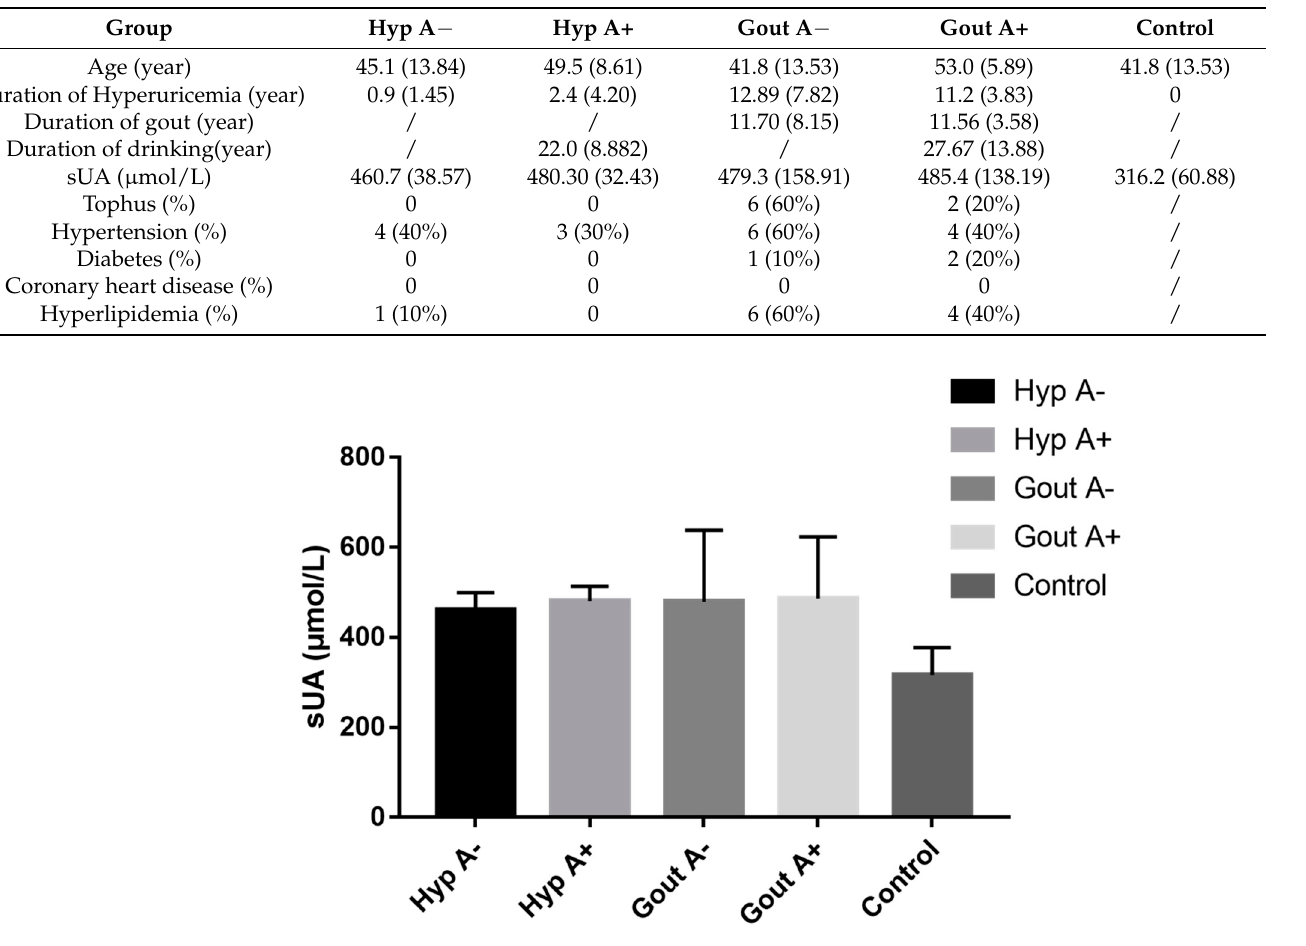
Figure 4. Serum uric acid levels between the different groups.